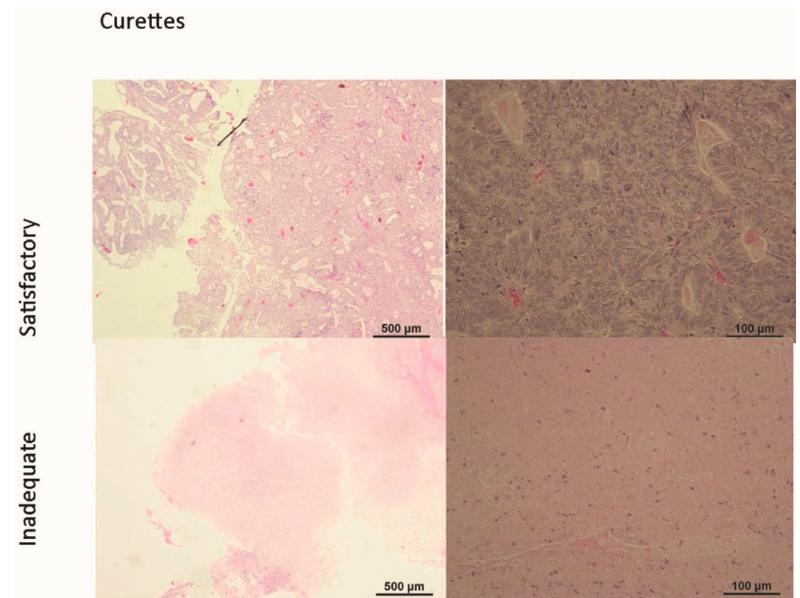
Figure 1. Micrographs of endometrial biopsies obtained during diagnostic procedures from patients with endometrial cancer. Pipelle (upper panel) and curettage (lower panel) samples may contain either